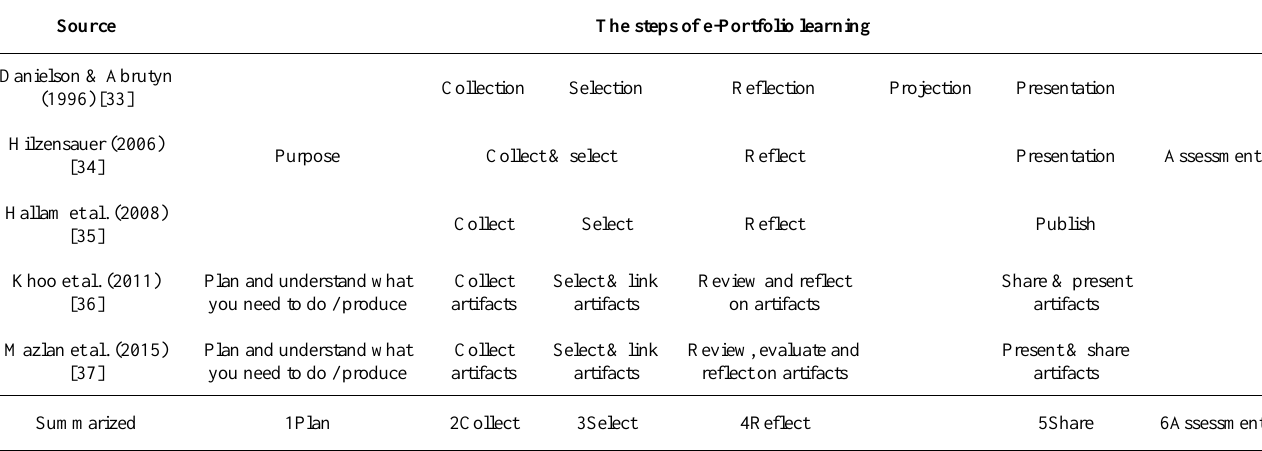
Table 1. The comparisons among different e-Portfolio